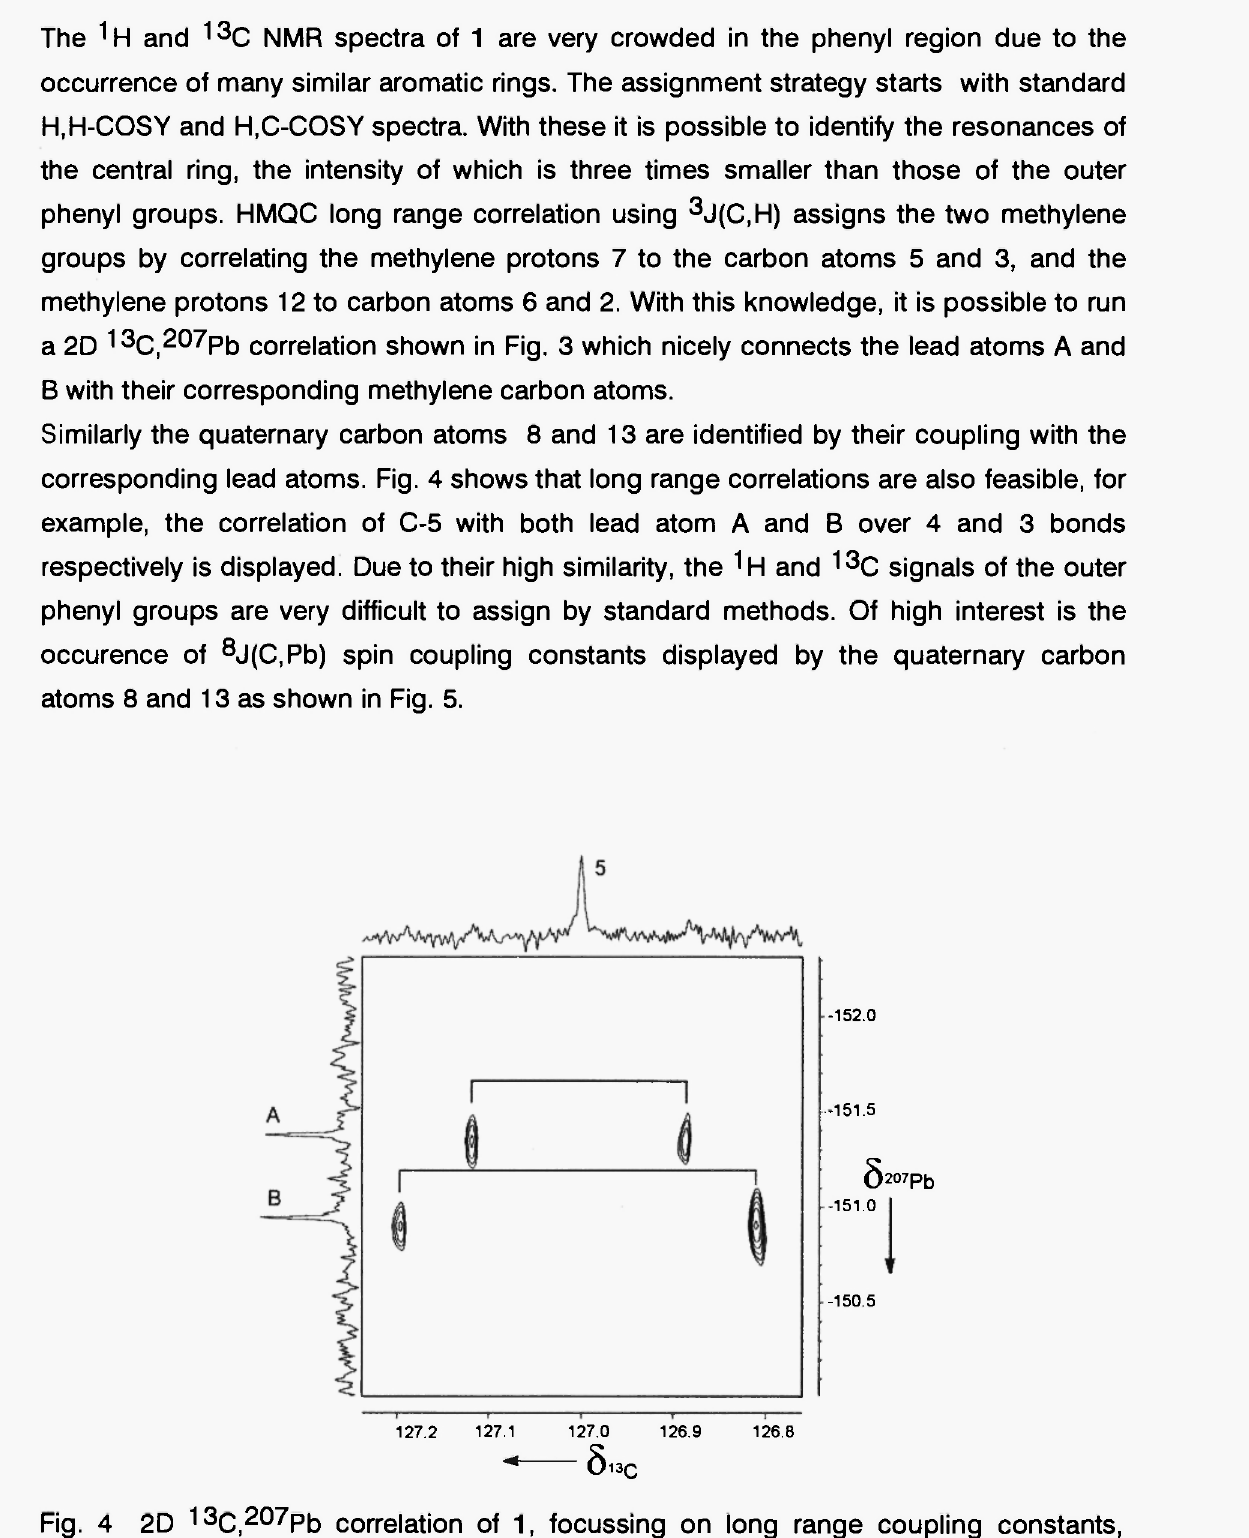
Fig. 4 2D 13 C, 207 Pb correlation of 1, focussing on long range coupling constants, shown is the expansion for carbon atom C-5 .